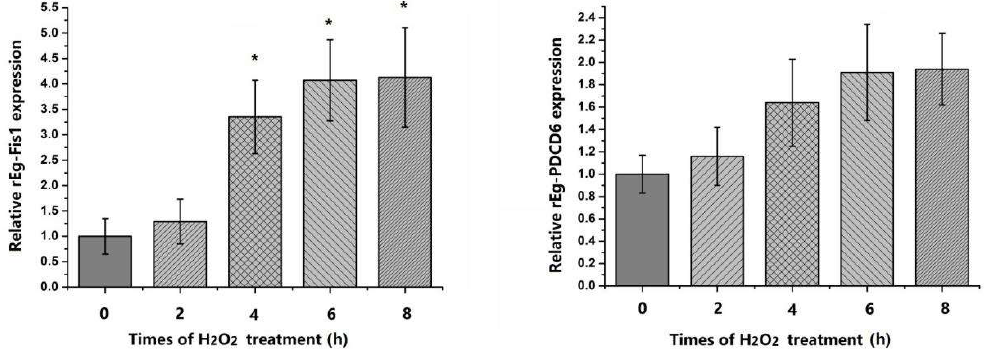
Figure 5. Expression profile analysis of Eg-Fis1 and Eg-PDCD6 in response to H 2 O 2 treatment. Data